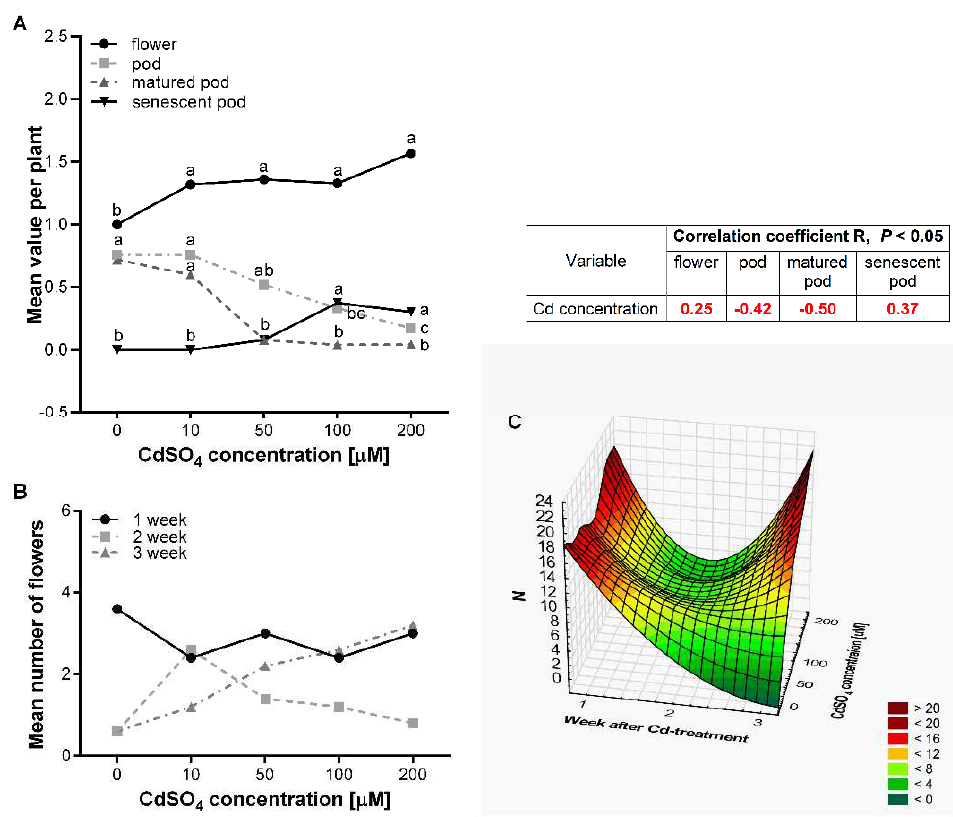
Figure 4. Flowering and pod production of peas during the experiment and Cd-treatment ( A – C ). ( A )—The number of flowers, pods, matured pods and senescent pods after Cd-treatment. Each value is the mean of three replicates ± SD. Different letters represent significant differences ( p < 0.05); The statistically significant results of the correlation analysis are presented as Pearson’s correlation coefficients (R). ( B , C )—Mean ( B ) and sum ( C ) of flowers produced after 1, 2 and 3 weeks of Cd- treatment.